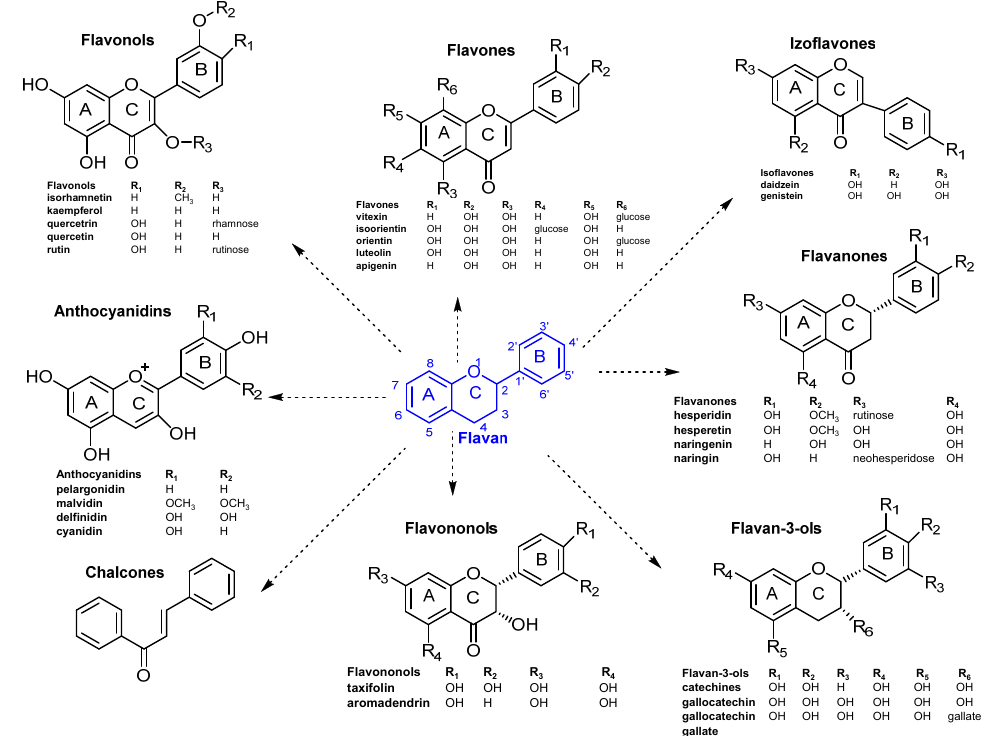
Figure 1. Chemical structures of important flavonoid sub-classes.